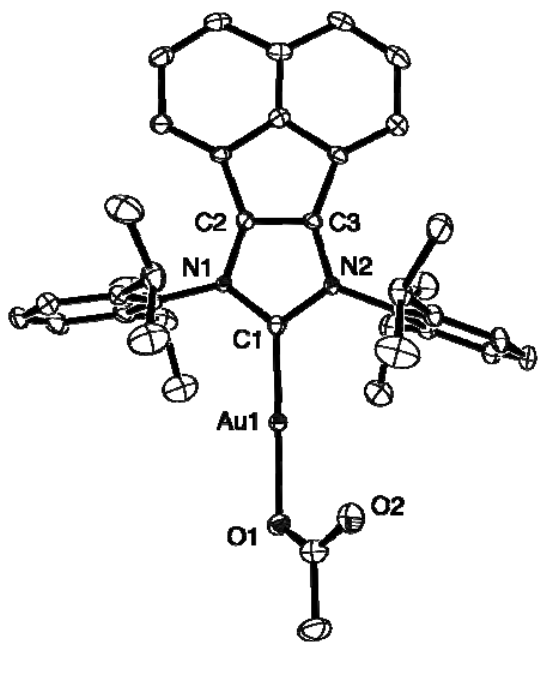
Figure 1. ORTEP diagram of 5 with 30% probability thermal ellipsoids. Hydrogen atoms are omitted for